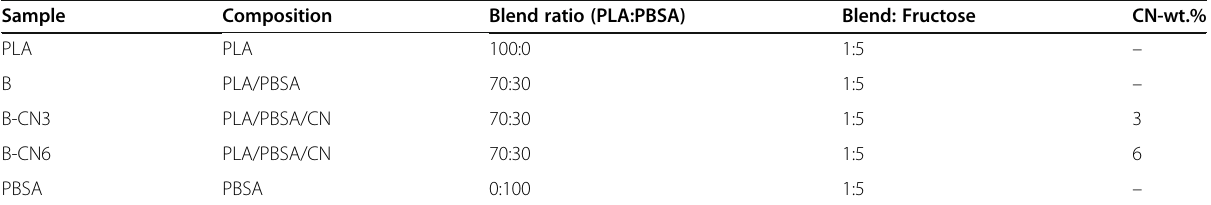
Table 1 Compositions of the prepared foams